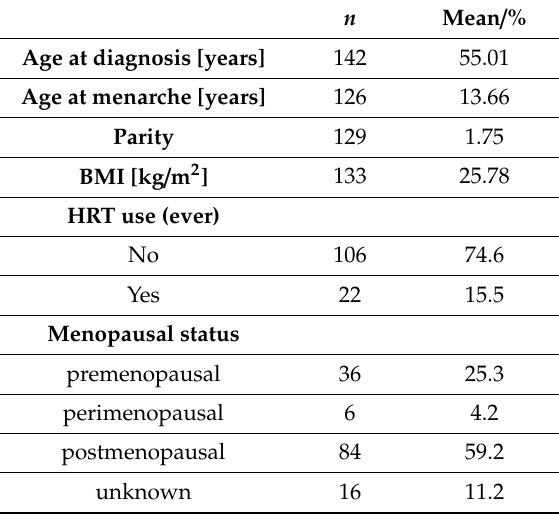
Table 1. Patients and tumor characteristics.